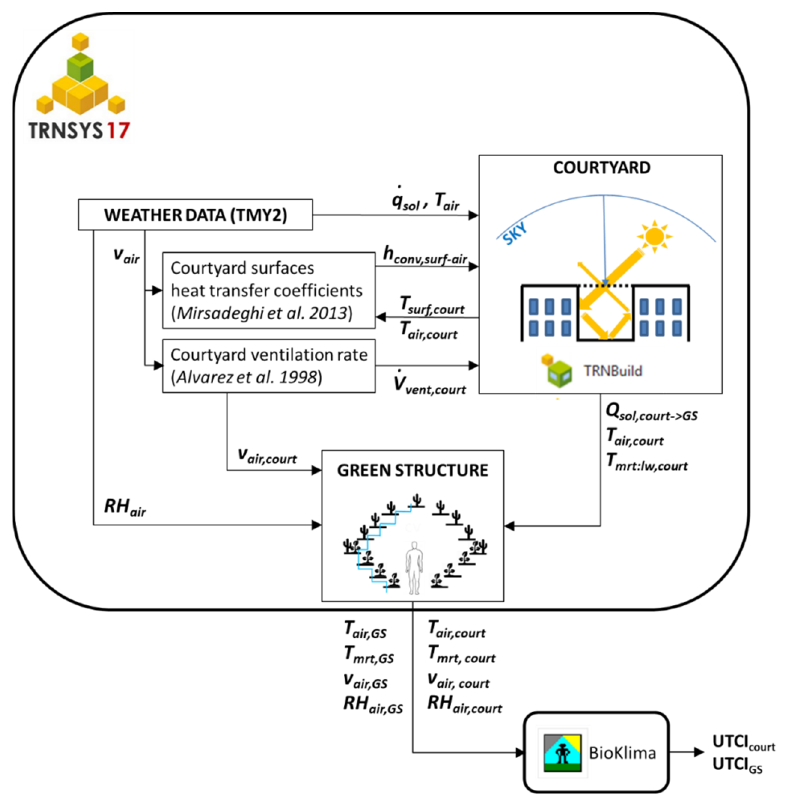
Figure 8. The schematic diagram of the courtyard and the GS model in TRNSYS, and its coupling with BioKlima. Energies 2020 , 12 , x FOR PEER REVIEW